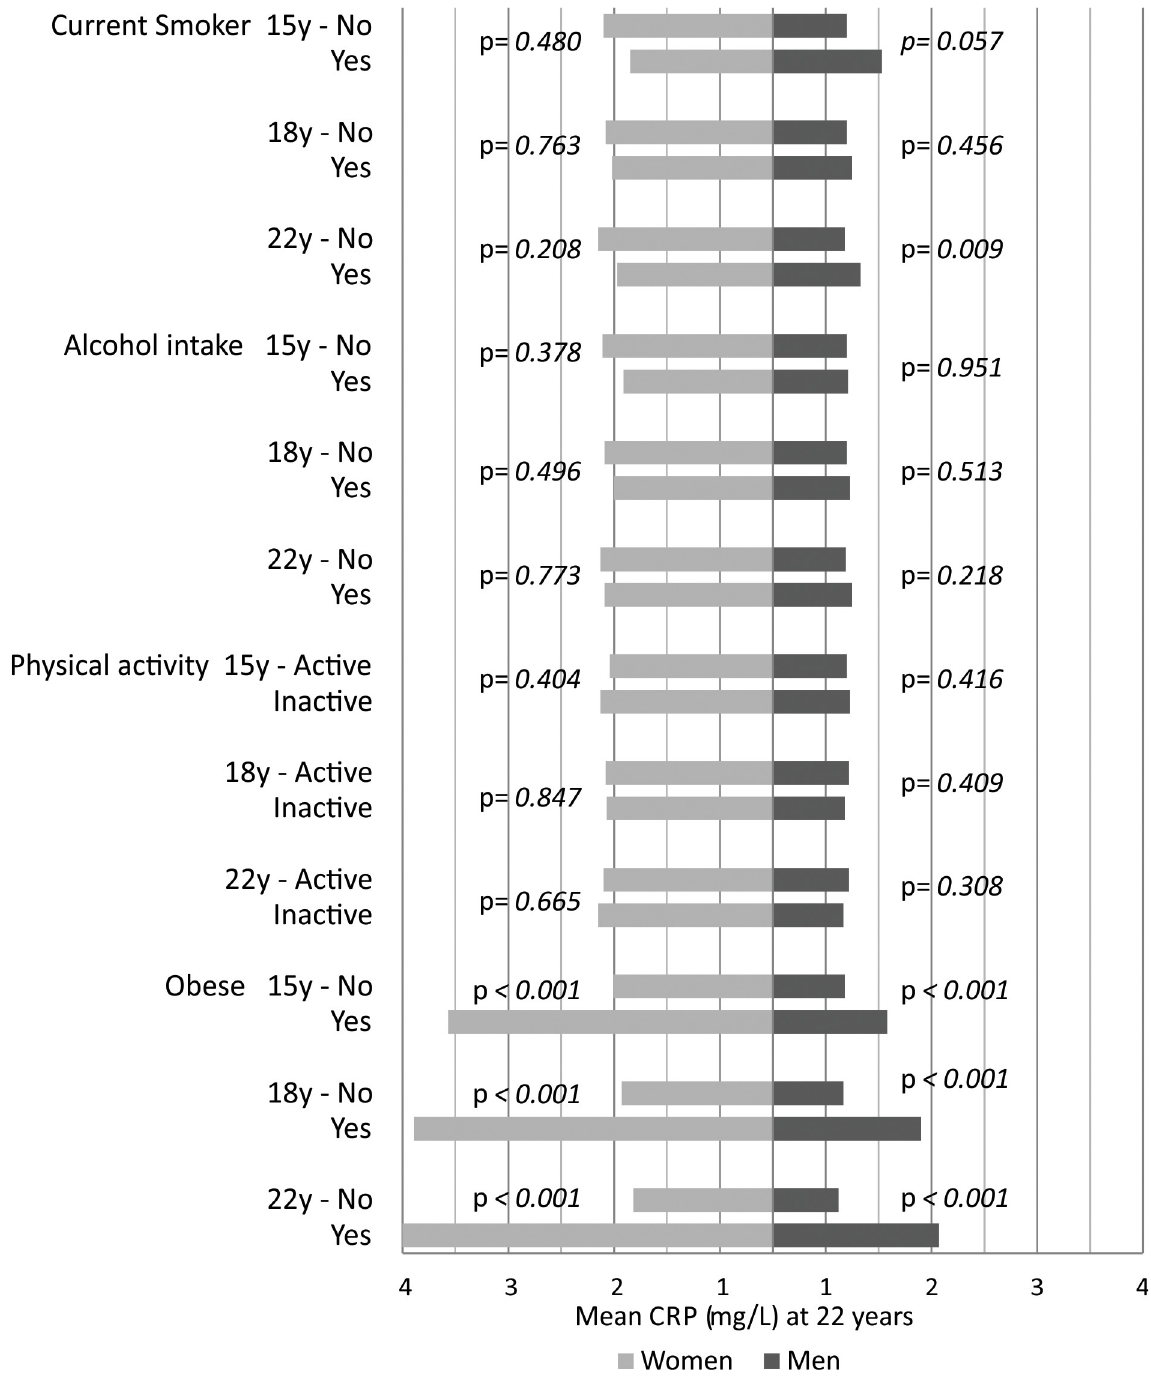
Fig 3. Mean levels of C-reactive protein at 22 year follow-up according to smoking, alcohol intake, physical activity and obesity at 15, 18 and 22 years. The 1993 Pelotas Birth Cohort.